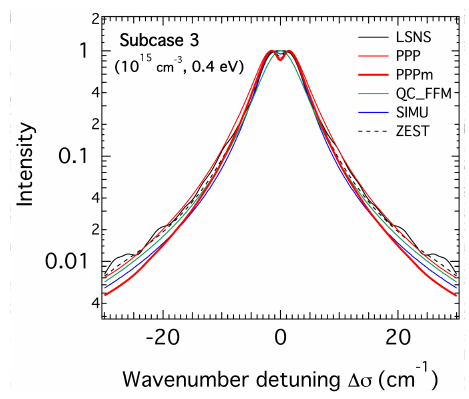
Figure 9. The theoretical Stark profiles of the H- β line of Figure 3 (T e = T i = 0.4 eV) with the inclusion of modified PPP calculations (PPPm: thick red solid line) where the electron density was scaled down by the mean corresponding factor explained at the end of Section 3.3. The factor used here is 1.2.